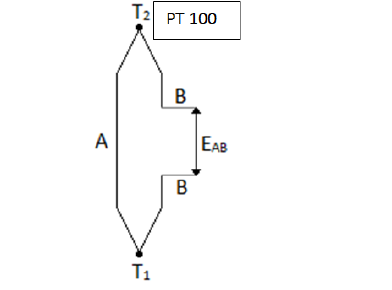
Fig. 4. Schematic diagram of actual temperature measurement system